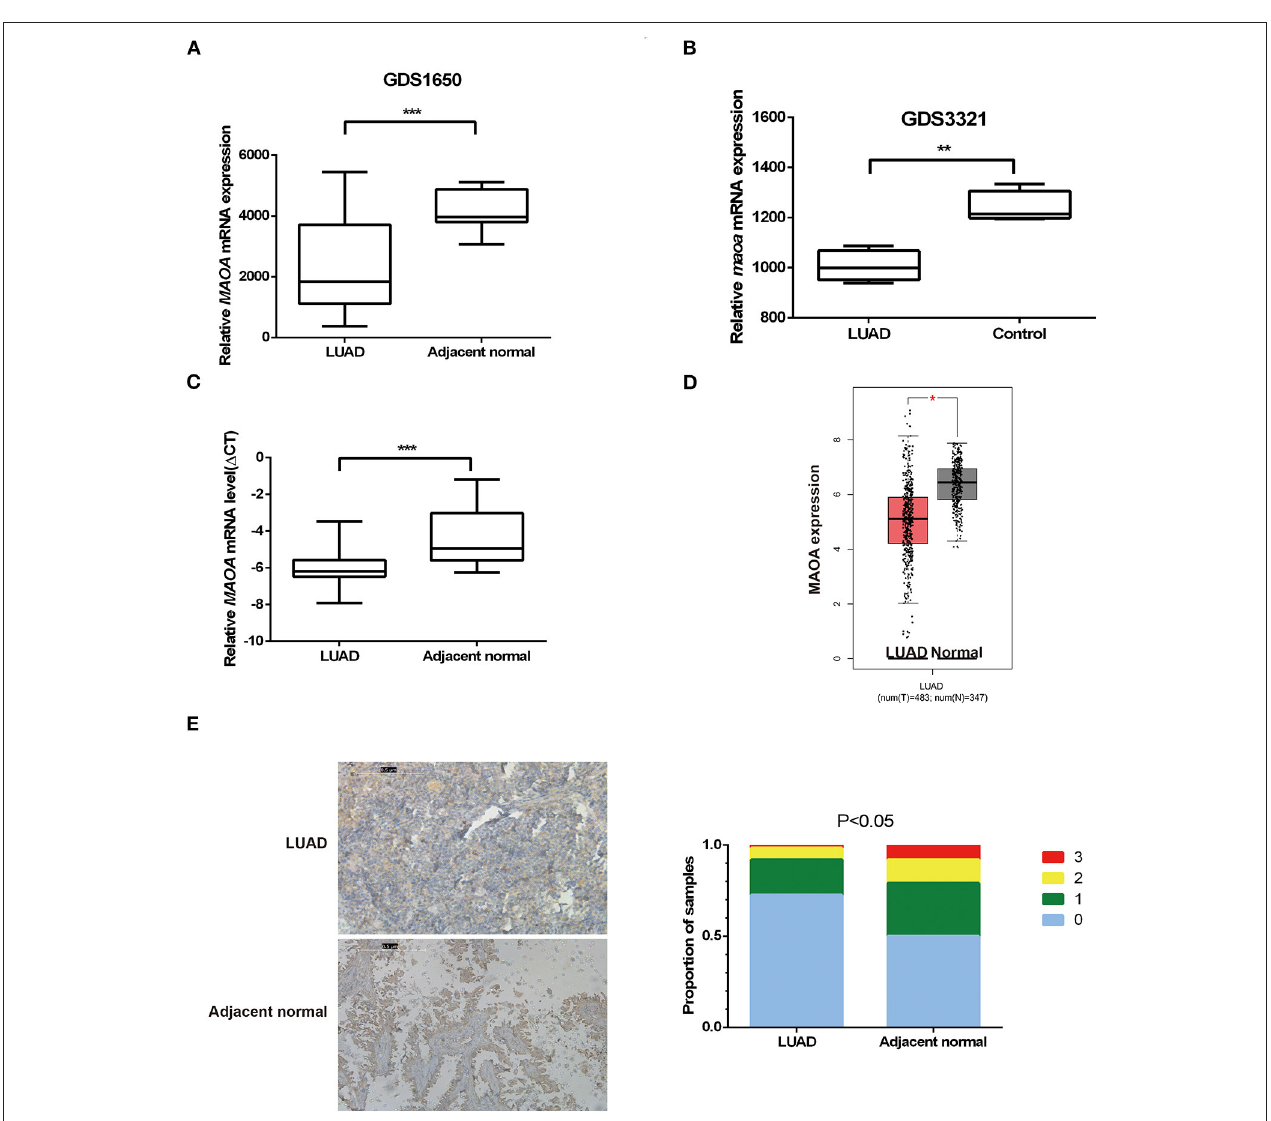
FIGURE 1 | The expression of monoamine oxidase A (MAOA) in lung adenocarcinoma (LUAD). The expression of MAOA in gene expression omnibus (GEO) data (A) , 19 pairs of human LUAD specimens (B) , 15 pairs of mice induced LUAD, 108 human LUAD specimens (C) , and the gene expression profiling interactive analysis (GEPIA) database (D) . The immunohistochemistry (IHC) detection of MAOA in human LUAD specimens (E) . * p < 0.05, ** p < 0.01, and *** p < 0.001, compared with non-tumor tissues.